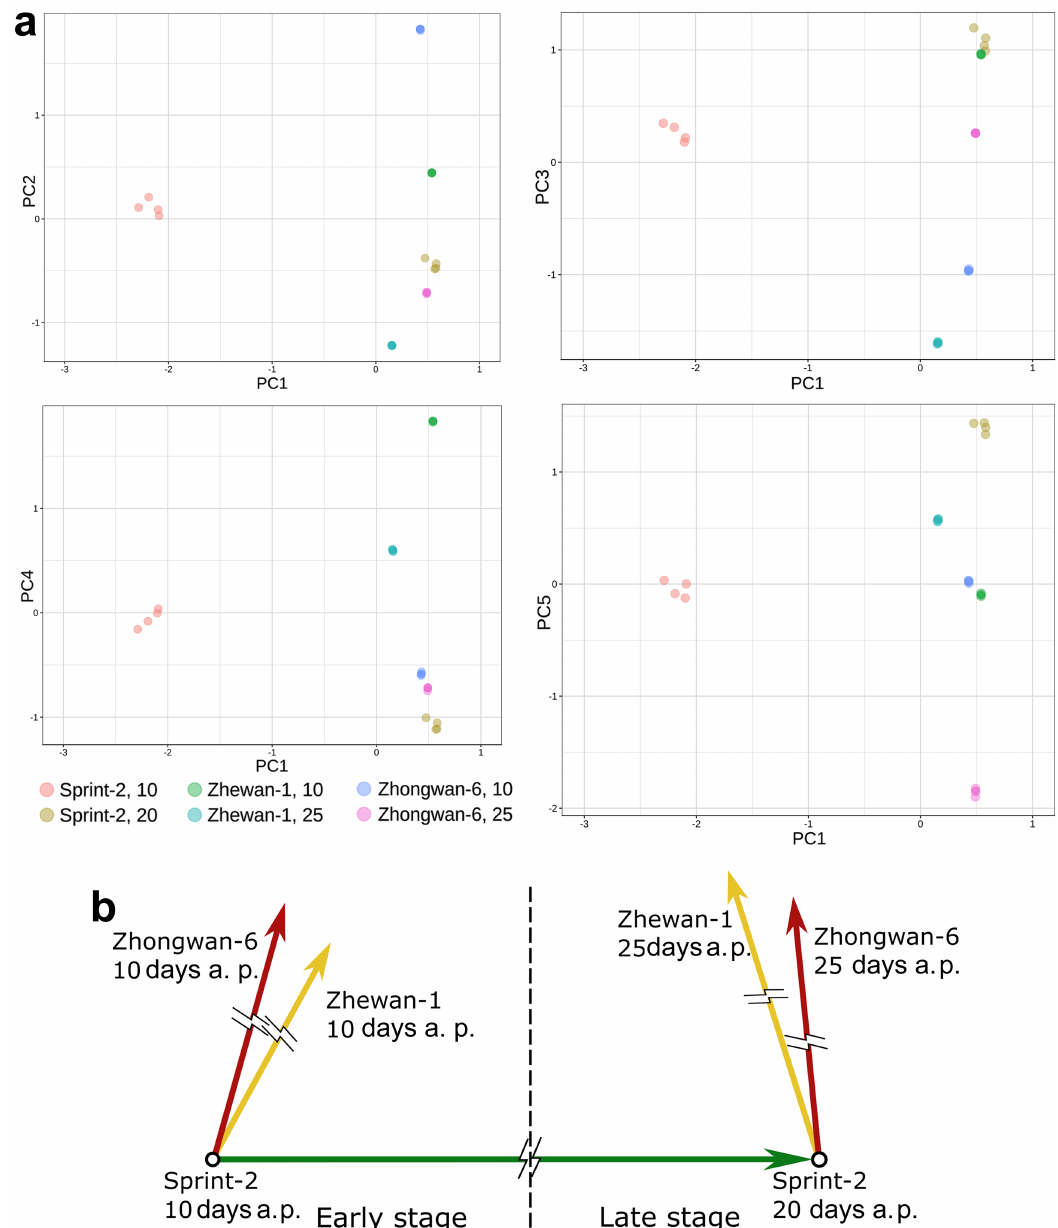
Figure 8. Discrepant maturation dynamics in Sprint-2 observed at a full-transcriptome scale. ( a ) Principle component analysis of three pea cultivars at two time points. Clustered values are vectors of transcripts per million values for respective samples. Primary components explain the percentage of observed variance, as follows: PC1: 60.0%; PC2: 11.9%; PC3: 8.9%; PC4: 5.2%; PC5: 4.2%. ( b ) Vectors of transcriptomic changes connecting states: from Sprint-2 10 days to Sprint-2 20 days (green vector), from Sprint-2 10 days to Zhongwan-6 10 days (red) and Zhewan-1 10 days (yellow), and from Sprint-2 20 days to Zhongwan-6 25 days (red) and Zhewan-1 25 days (yellow), are shown. Angles between vectors correspond to the arccosine of cosine similarity between vectors. The timeline of maturation is along the vector Sprint-2 10–20 days. Length of the vectors was chosen arbitrarily. Self-organizing map (SOM) clustering of the transcriptomic landscape (Figure 9a, Table S15, File S2) indicated features separating samples into several distinct groups. The group